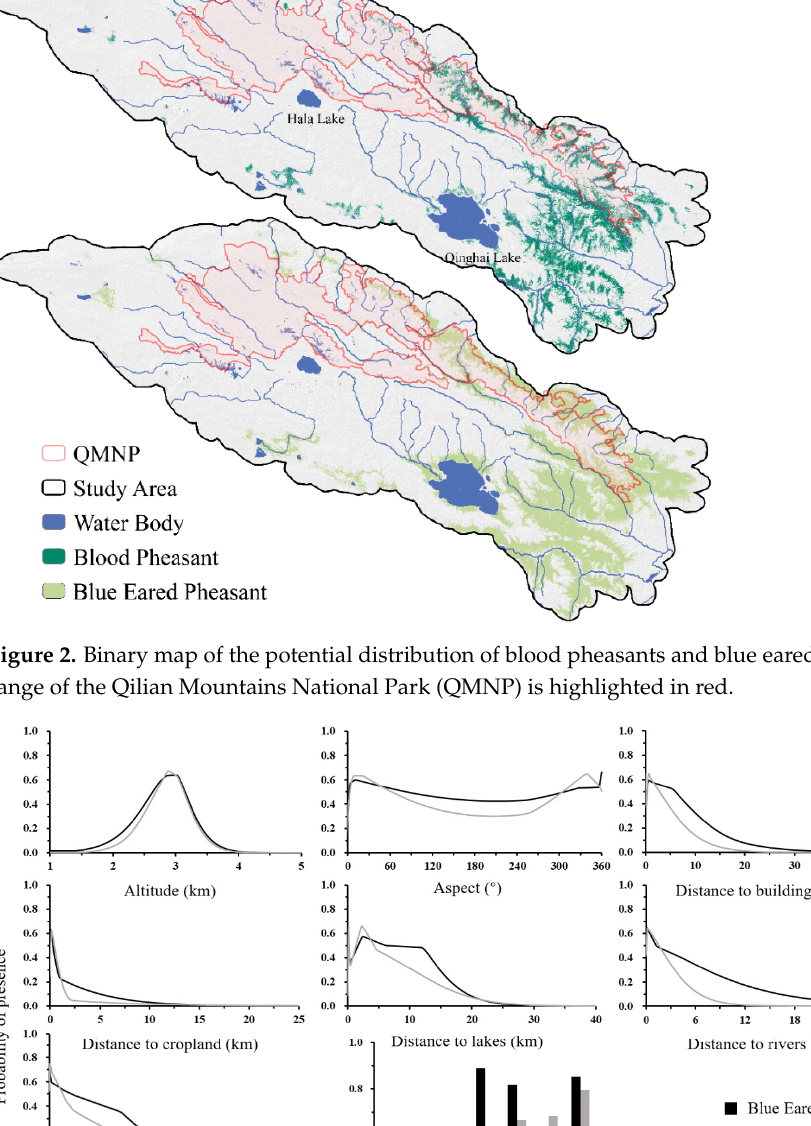
Figure 3. Probability of presence in reaction to different variables. Forest type A: closed evergreen broadleaved forest, forest type B: closed deciduous broadleaved forest, forest type C: open ever- green needle-leaved forest, forest type D: closed evergreen needle-leaved forest, bare areas type A: bare areas, bare areas type B: consolidated bare areas, bare areas type C: unconsolidated bare areas.